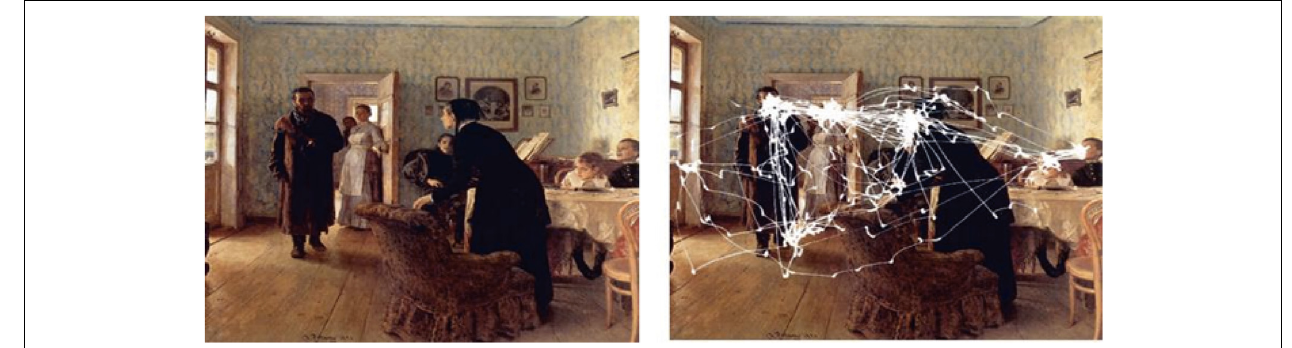
FIGURE 1 | Left:The oil painting “An UnexpectedVisitor” painted by Ilya Repin. Right: an example of an eye trace measured byYarbus during the free viewing condition (1967).This figure was originally referred from http://www.cabinetmagazine.org/issues/30/archibald.php.